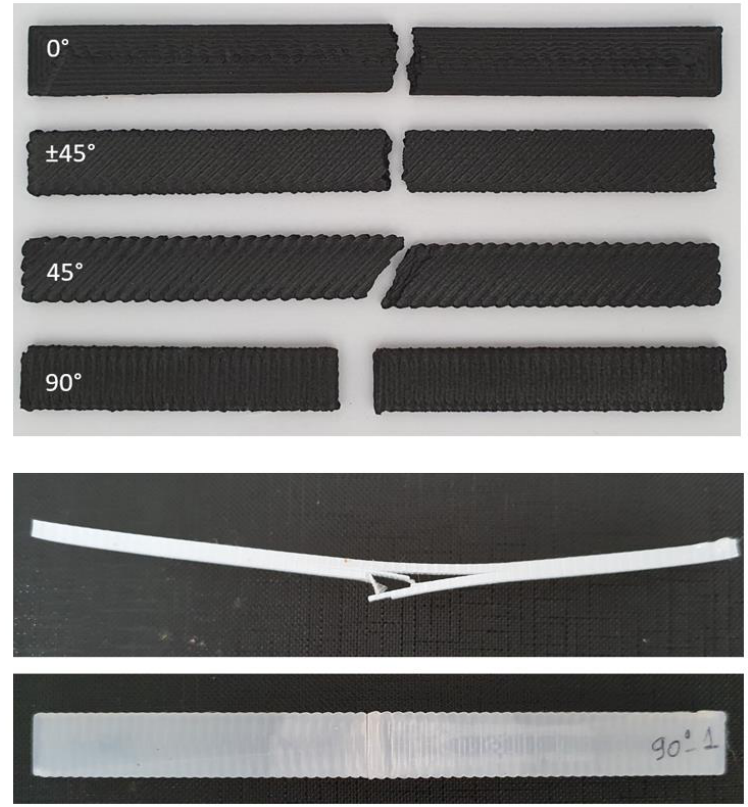
Figure 10. Failed samples of 3-point bending tests.